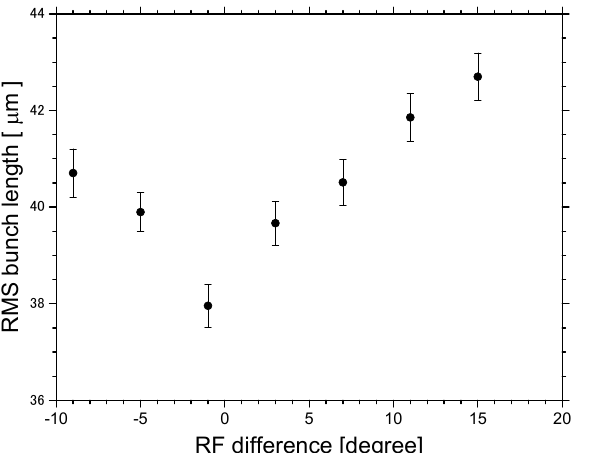
Figure 7. Evaluated RMS bunch length of the main pulse for the measured CER spectrum at ∆ = +15° in the satellite pulse model.